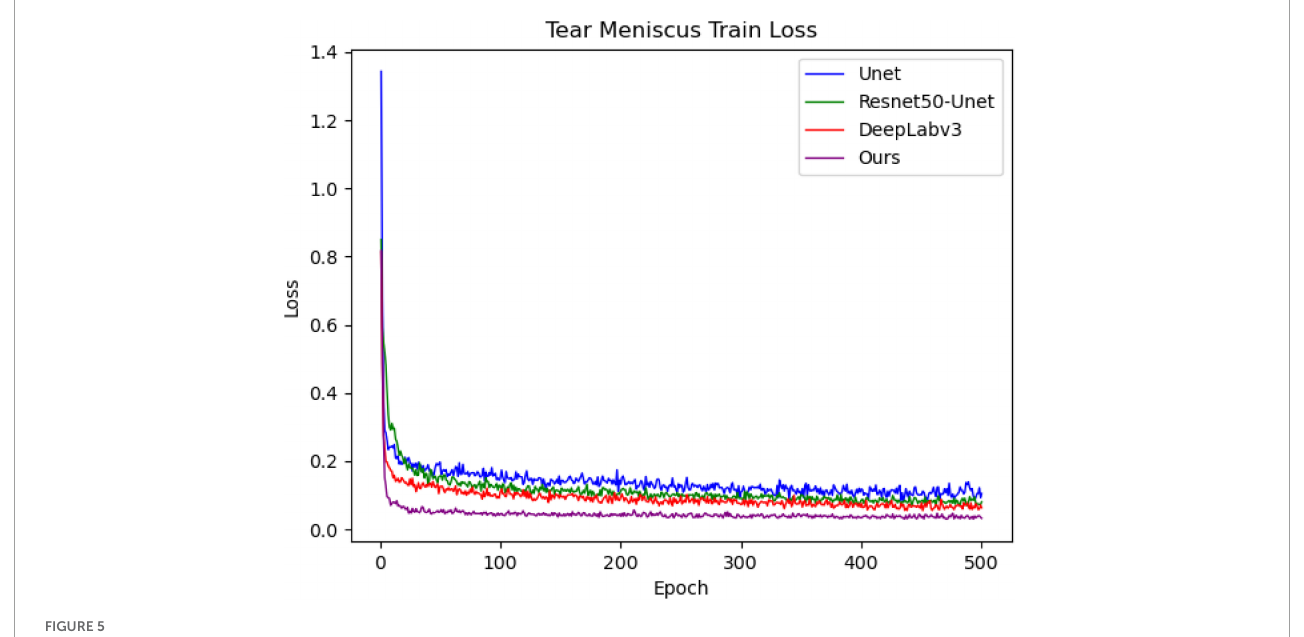
FIGURE5 Loss of training process for tear meniscus segmentation by different models.